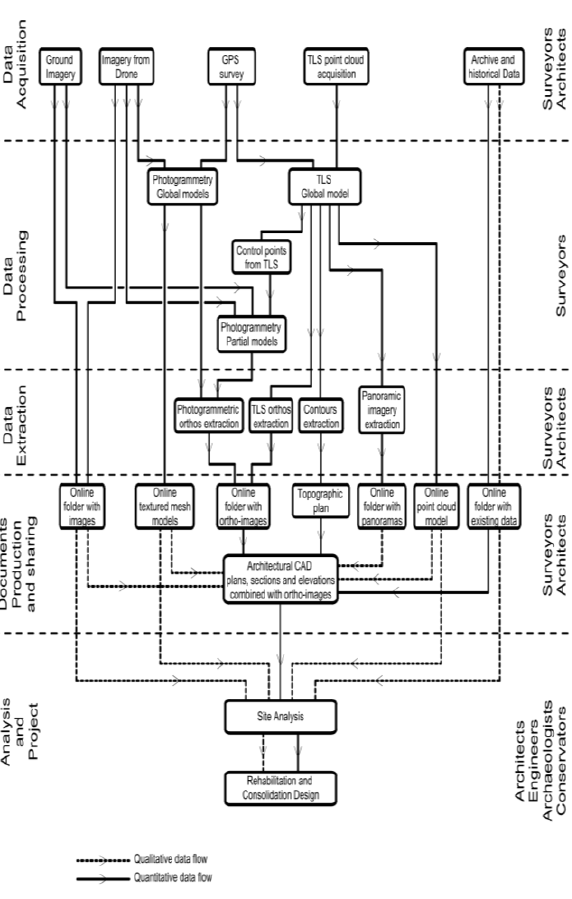
Figure 2. Graphical data flow: quantitative and qualitative. Four main types of data were collected in the first phase of the project: Terrestrial and aerial photos, providing a relevant set of data containing accurate texture information. The capture configuration followed the principle of Stereo Photogrammetry, where all relevant features where documented at least in a stereo pair. The aerial capture followed the principle of classic aerial photogrammetry: vertical photos with an overlapping of 80% in the longitudinal axis and 30% in the transverse axis. Approximately 10k photos were taken. For the aerial images it was used a DJI Phantom 4